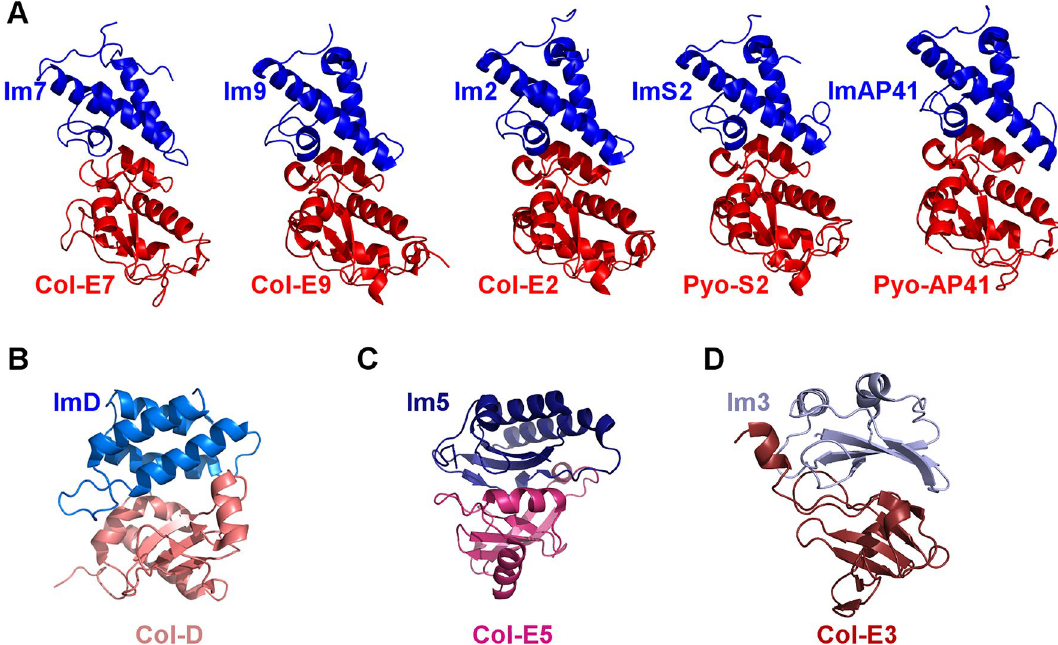
Figure 1. Colicins/pyocins and their cognate immunity proteins can be classified into four families based on structural similarity. Structures of different colicin/pyocin–immunity protein complexes (with representative PDB IDs), shown as ribbon diagrams (colored in shades of red and blue, respectively), can be divided into four families based on structure alignment. ( A ) The E7/Im7-like family: Col-E9–Im9 (1EMV), Col-E2–Im2